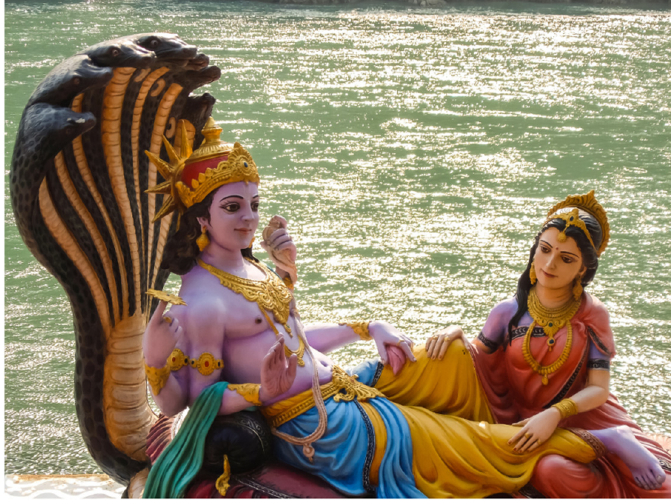
Figure 3. This is a picture of Ā di Ś es ̣ a ( Īś vara pra ṇ idh ā na ) holding and being devoted to Vi ṣṇ u ( tapas ) and Lak ṣ m ī ( sv ā dhy ā ya ), described as the essential practice of Yoga (YS II.1) floating on top of waves (YS I. I.2-3). Lak ṣ m ī , sv ā dhy ā ya , is also depicted here as forming a bond with her chosen ideal, as per